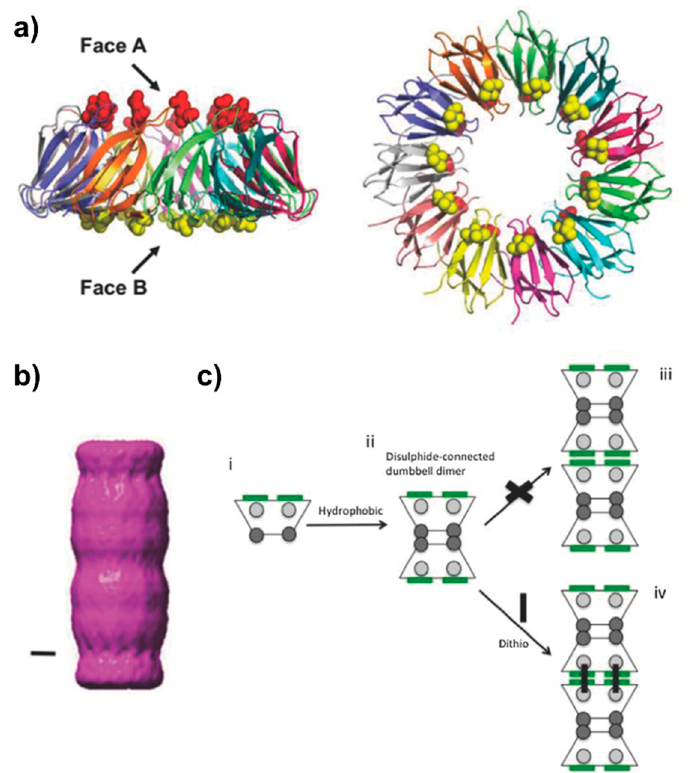
Figure 5. Design and assembly of PNTs of a mutant form of trp RNA-binding attenuation protein (TRAP) from G. stearothermophilus . ( a ) Side-on (left) and top-down (right) views of TRAP (PDB ID 1QAW [91]), colored by chain. The narrower “A” face harbors residue 50 (red sphere), while the wider “B” face harbours residue 69 (yellow sphere). In the original description of the TRAP PNTs [16], residues L50 and C69 allow for a hydrophobic-mediated interaction of the narrow “A” faces, and a dithio-mediated (such as via dithiothreitol, DTT) interaction of the “B” faces due to the steric bulk surrounding C69. ( b ) S Single particle analysis of the initial PNT forming “Tube TRAP” (TT) (scale bar represents 2 nm) [16], which was further modified to generate longer, more stable PNTs [18]. ( c ) Mutation L50C generates a di-cysteine mutant (TT CC ) resulting in a much more stable PNT. Mechanistically, C50 on the narrow face (grey circles) can initially form direct disulfide bonds to form the initial TRAP dumbbell dimer; steric considerations prevent C69 interactions at this point. Addition of a dithio linker crosslinks the B faces via C69, resulting in an elongated TRAP PNT. Figure adapted with permission from Nagano et al. Adv. Mater. Interfaces 3 , 1600846 (2016) [18].